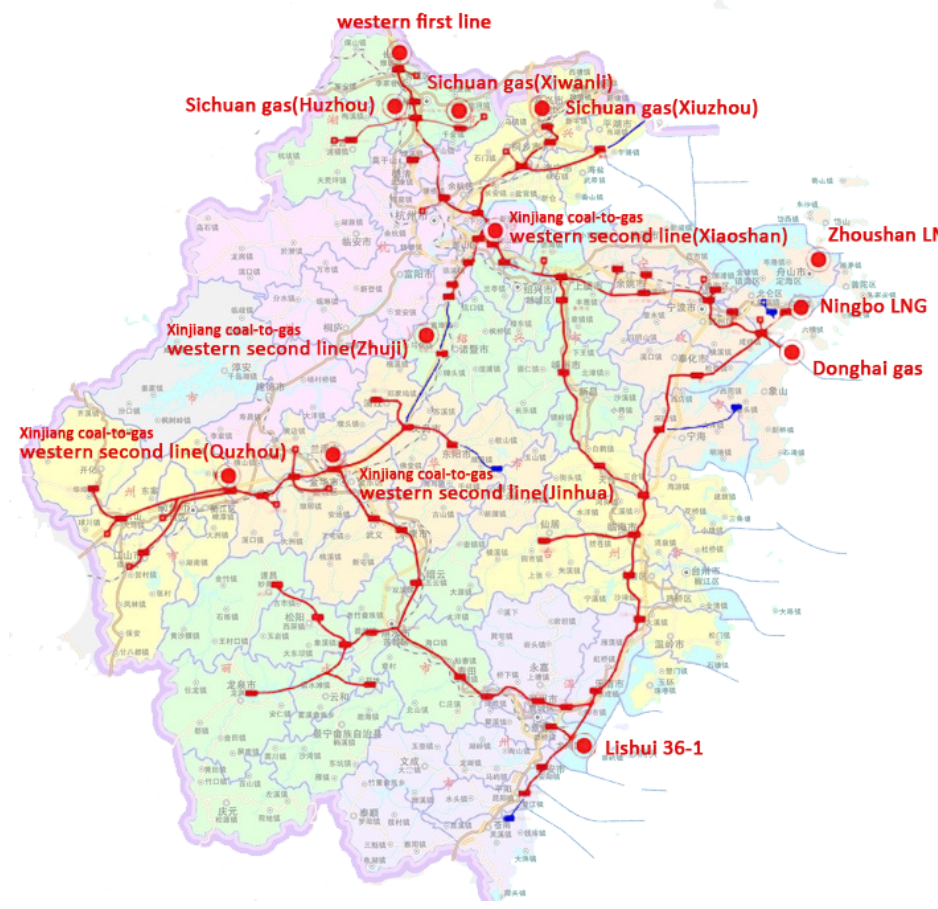
Figure 2. Zhejiang provincial pipeline network of natural